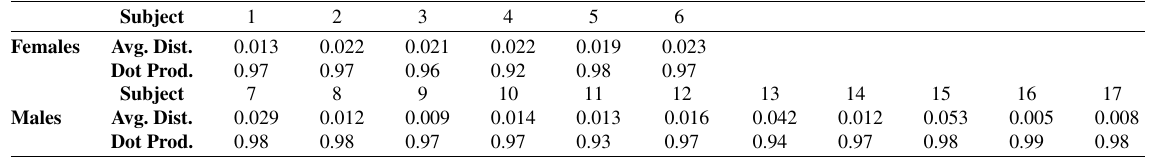
Table 2 set of motion